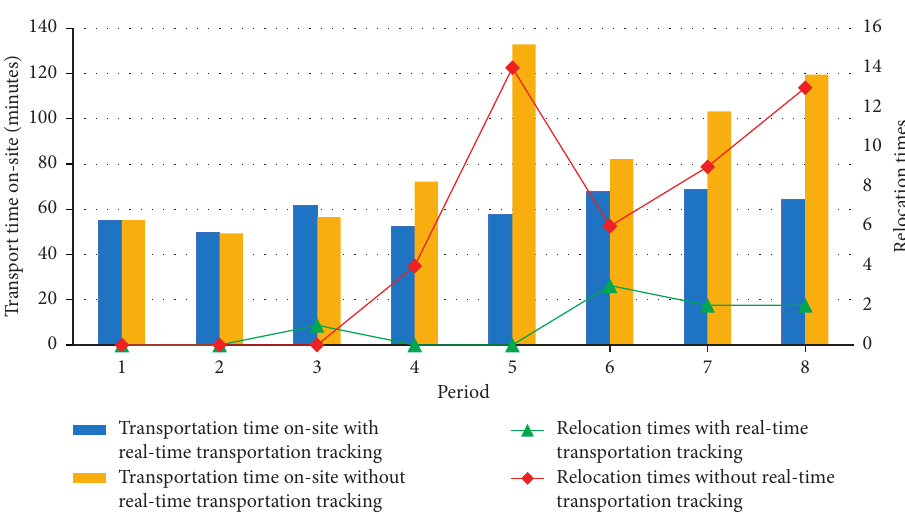
Figure 13: Comparison of the results of the control group model and the original